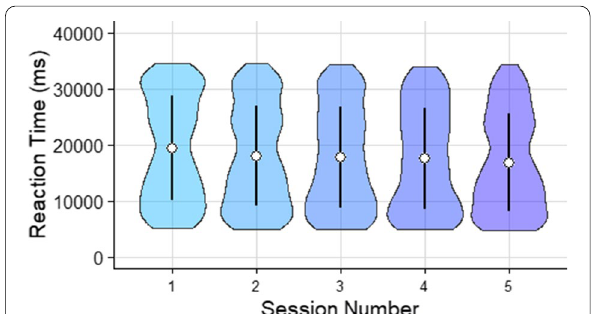
Fig. 8 Violin plot illustrating points earned per experimental testing session ( N Session 1 = 892, N Session 2 = 900, N Session 3 = 898, N Session 4 = 895, N Session 5 = 809). White circles indicate the mean. Error bars show ± 1 standard